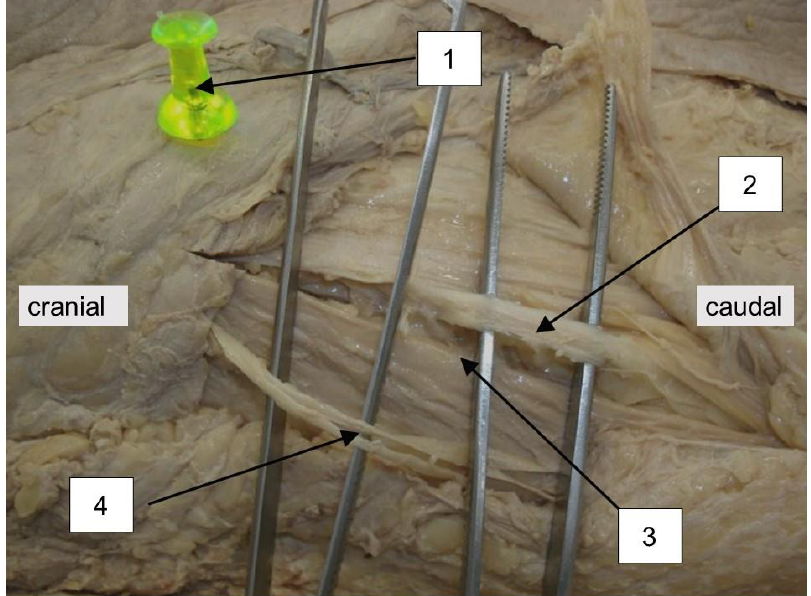
Figure 2. Topographic position of the LFCN to the line of the skin incision of the anterior approach. 1 = ASIS, 2 = LFCN, 3 = line of skin incision, 4 = ramus anterior of the Iliohypogastric